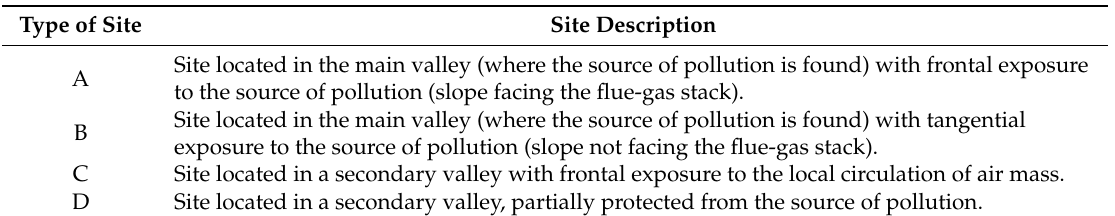
Table 2. Classification of sampled sites according to the location in relation to the source of pollution. Type of Site